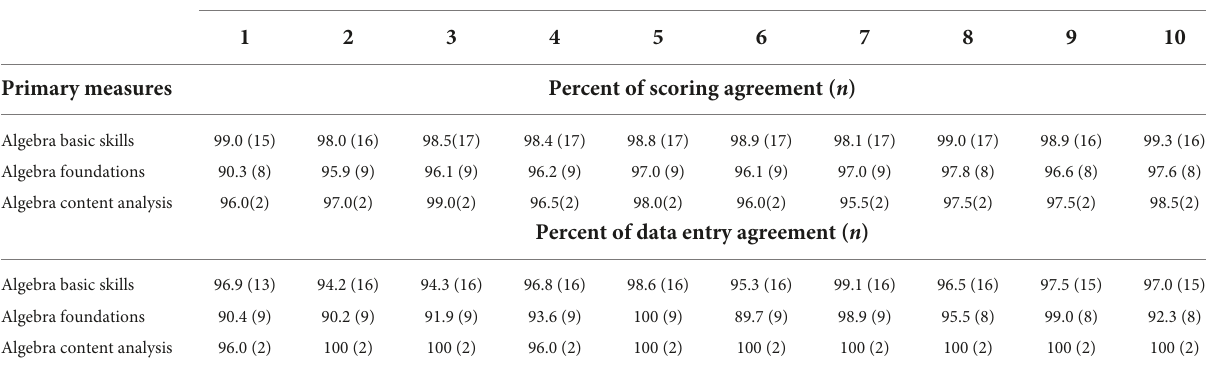
TABLE 5 Interrater agreement for scoring of measures and online data entry.